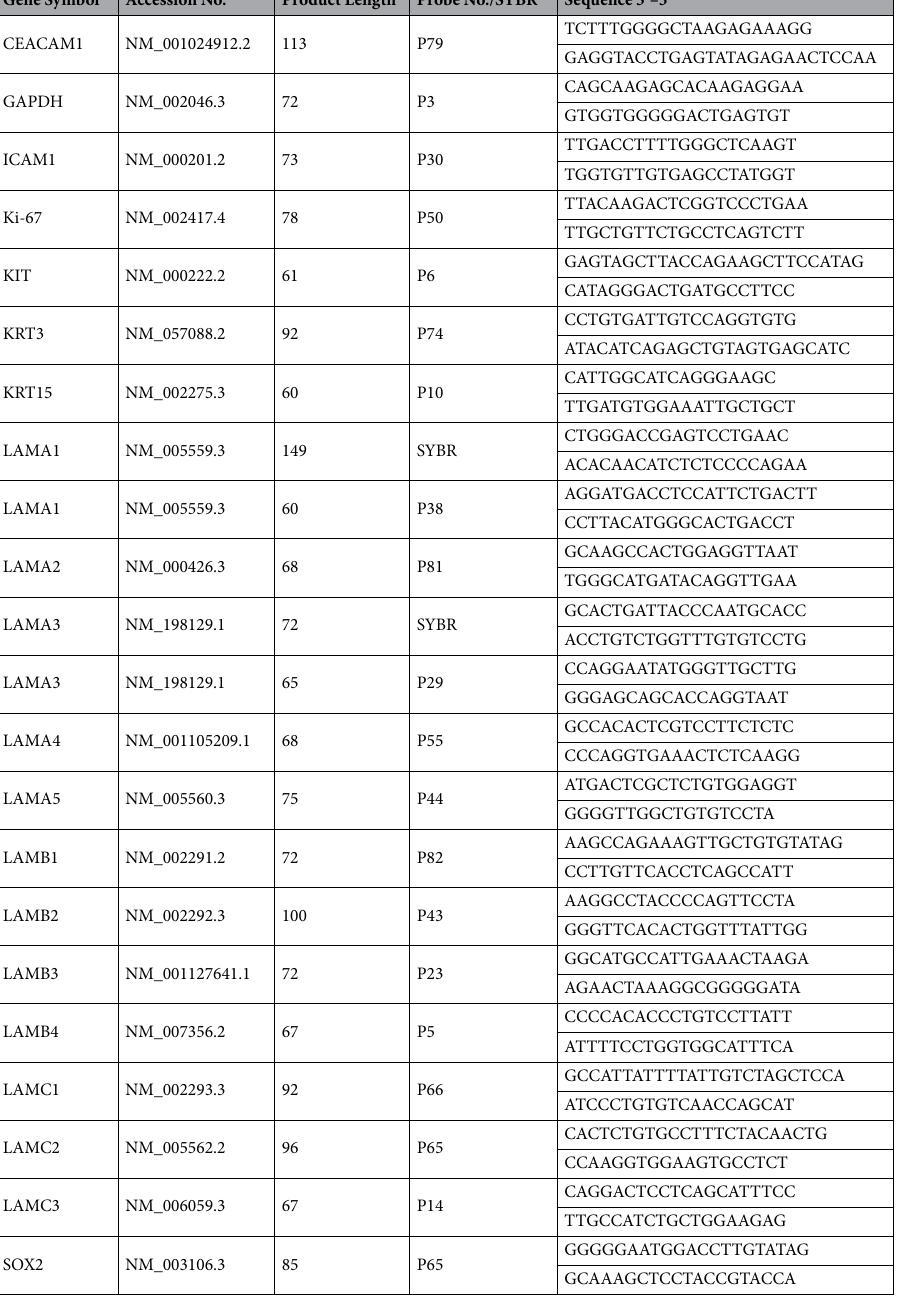
Table 2. Primers used in qRT-PCR primer assays. Primers were used for Probe based (Universal Probe Library) or SYBR Green based qRT-PCR assays with an annealing temperature of 60